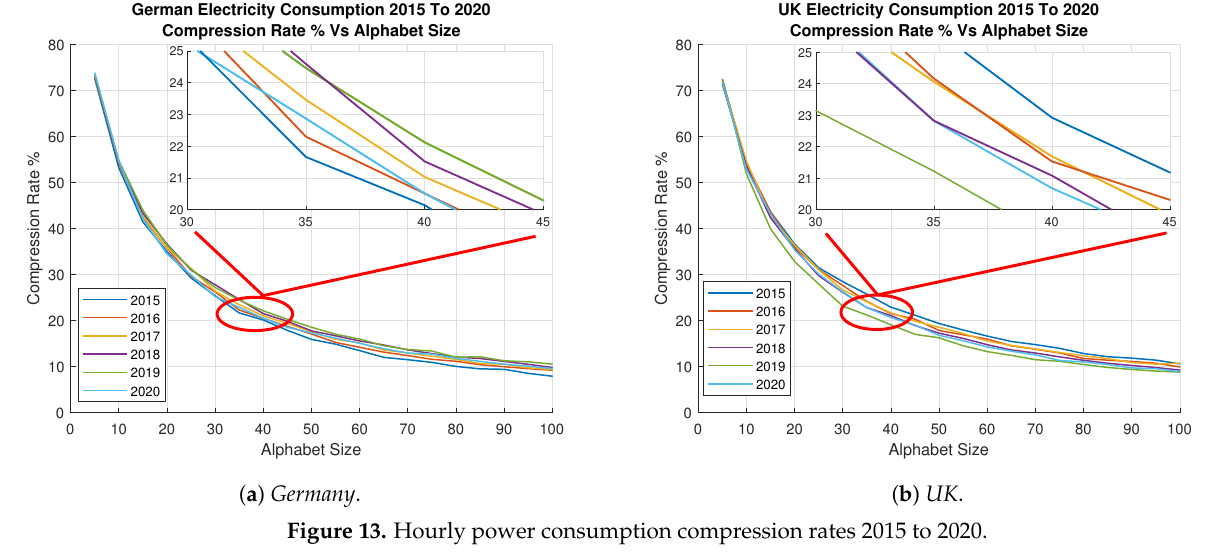
Figure 13. Hourly power consumption compression rates 2015 to